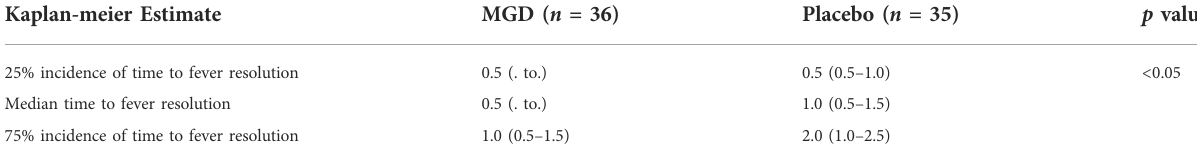
TABLE 4 Estimates for time to fever